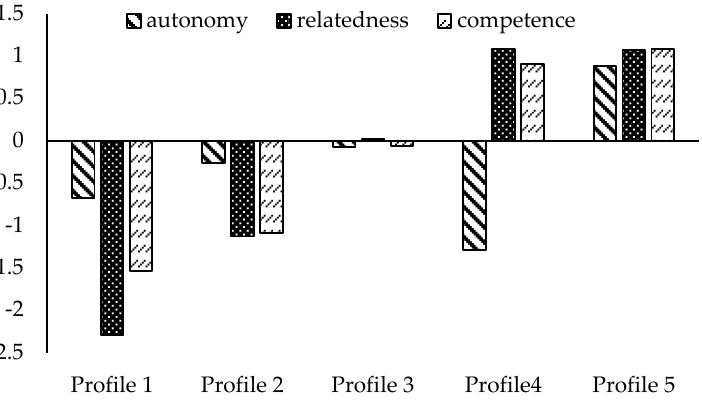
Figure 1. Basic psychological need satisfaction profiles of volunteers (Note. Scores for all three indicators were standardized).